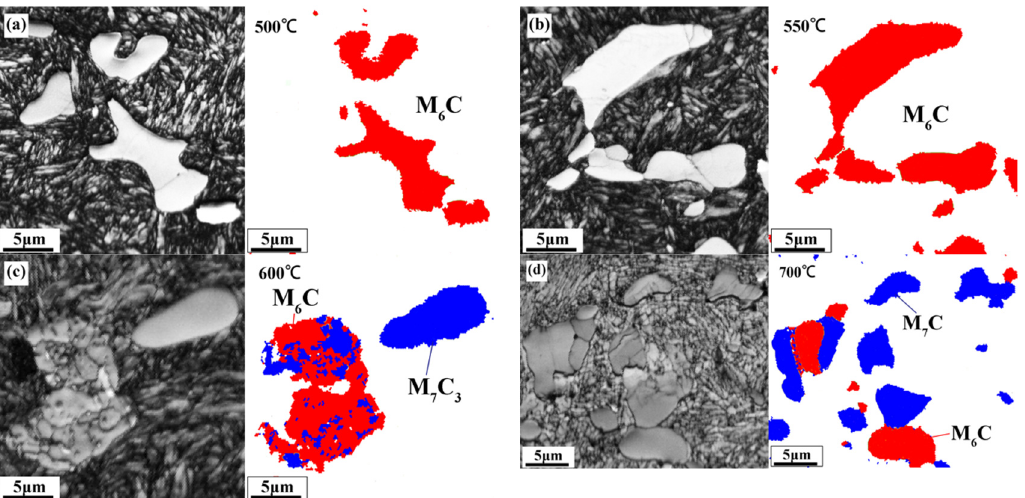
Figure 5. EBSD Band-Contrast Image and Phase Map of M42 HSS under different Tempering Temperatures: ( a ) 500 °C; ( b ) 550 °C; ( c ) 600 °C; ( d ) 700 °C.